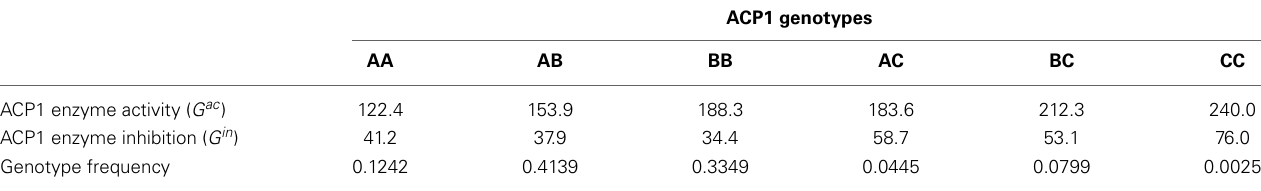
Table 1 | Expected genotypic values and observed genotype